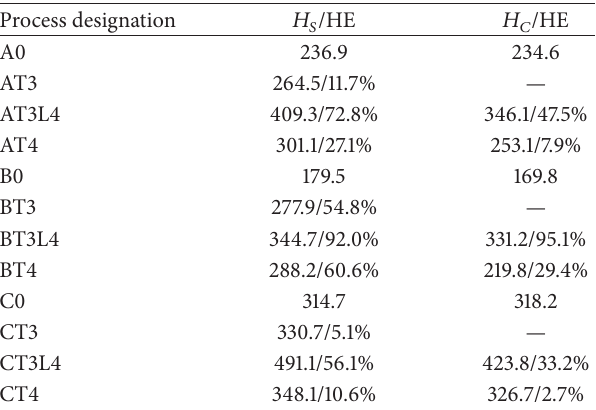
Table 7: Hardening efficiency for typical